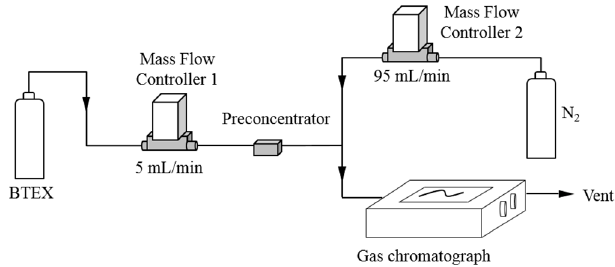
Figure 4. Schematic drawing of set-up used for breakthrough experiments.